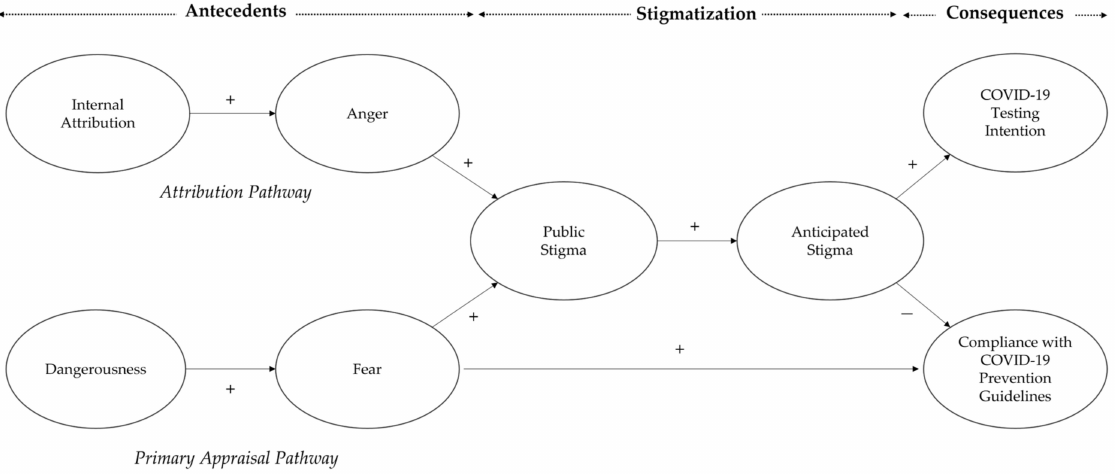
Figure 1. The conceptual model of the current study. Note: Positive sign (+) indicates a positive causal relationship between two variables whereas a negative sign ( − ) indicates a negative causal relationship between two